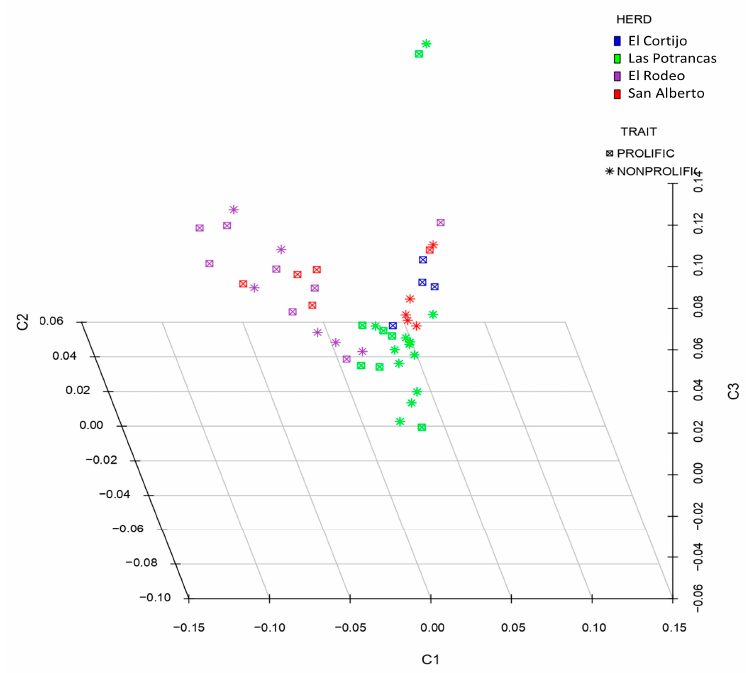
Figure 1. The multidimensional scale (MDS) analysis of genotypes included in this study. The analysis was performed for the first three components (C1, C2, and C3). The color indications for the herd are as follows: El Cortijo, blue; Las Potrancas, green; El Rodeo, purple; San Alberto, red.